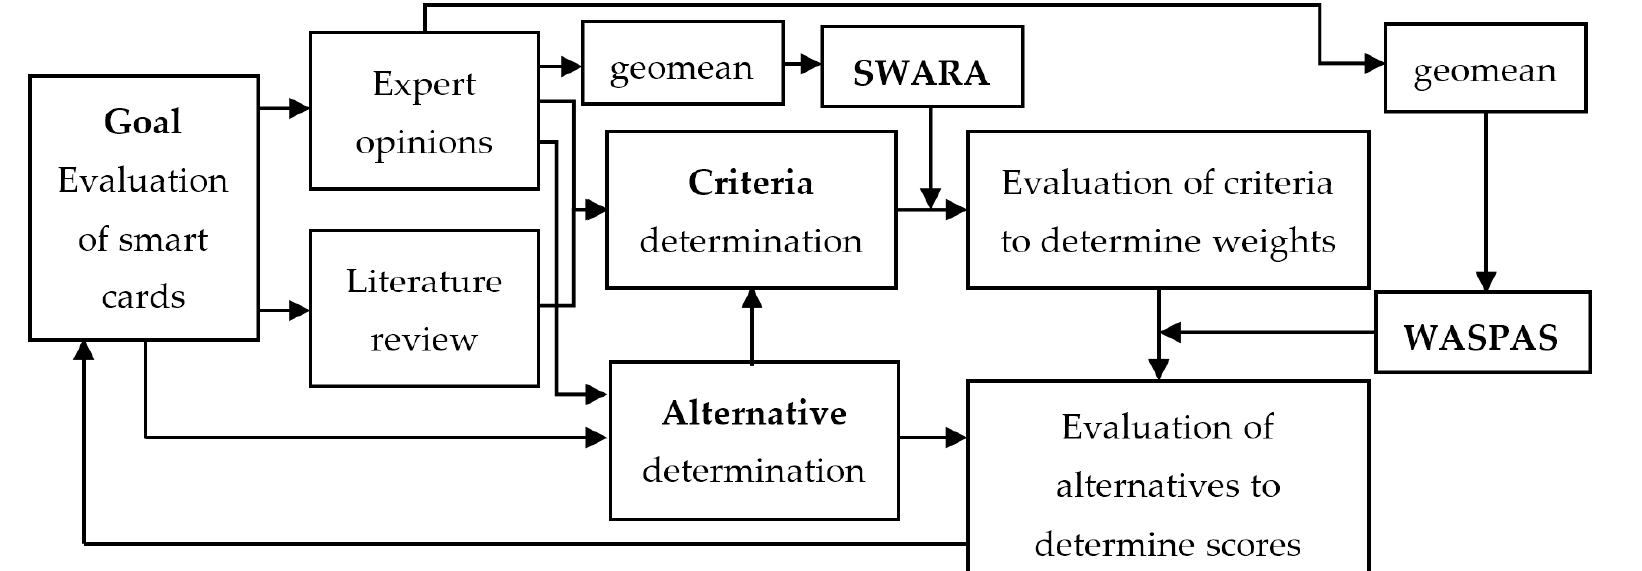
Figure 2. Framework of proposed SWARA-WASPAS integrated MCDM methodology.